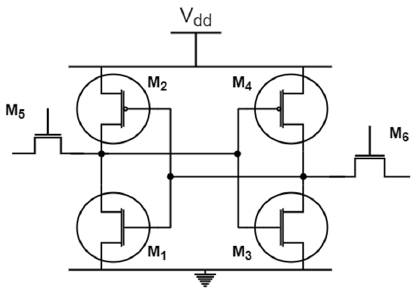
Figure 1. Model of SRAM cell.